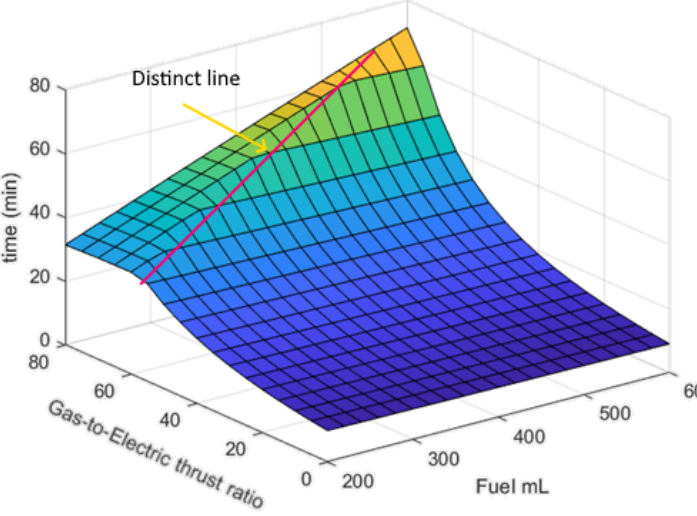
Figure 20. The flight time for a fixed 7500 mAh LiPo battery.